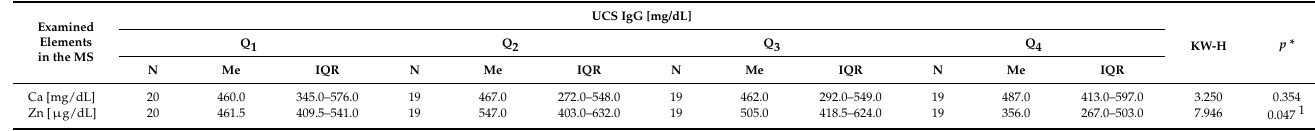
Table 7. The concentration of IgG antibodies in the UCS in relation to the concentration of Ca and Zn in the MS divided into quartiles.